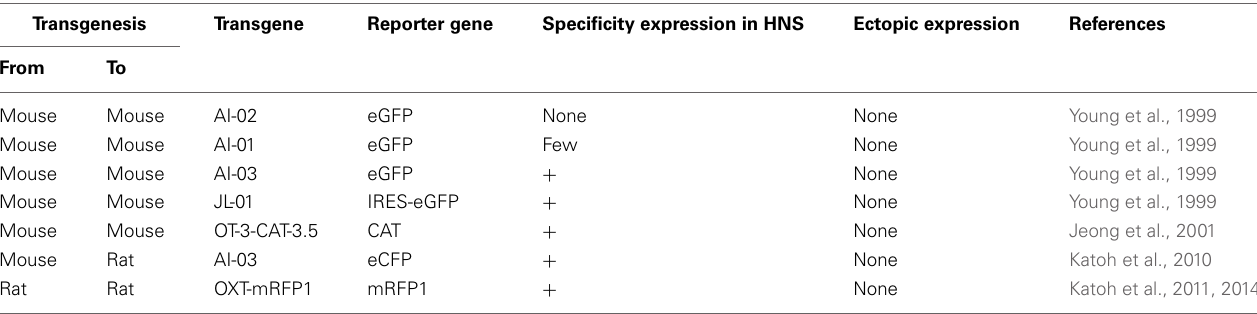
Table 1 | Oxytocin